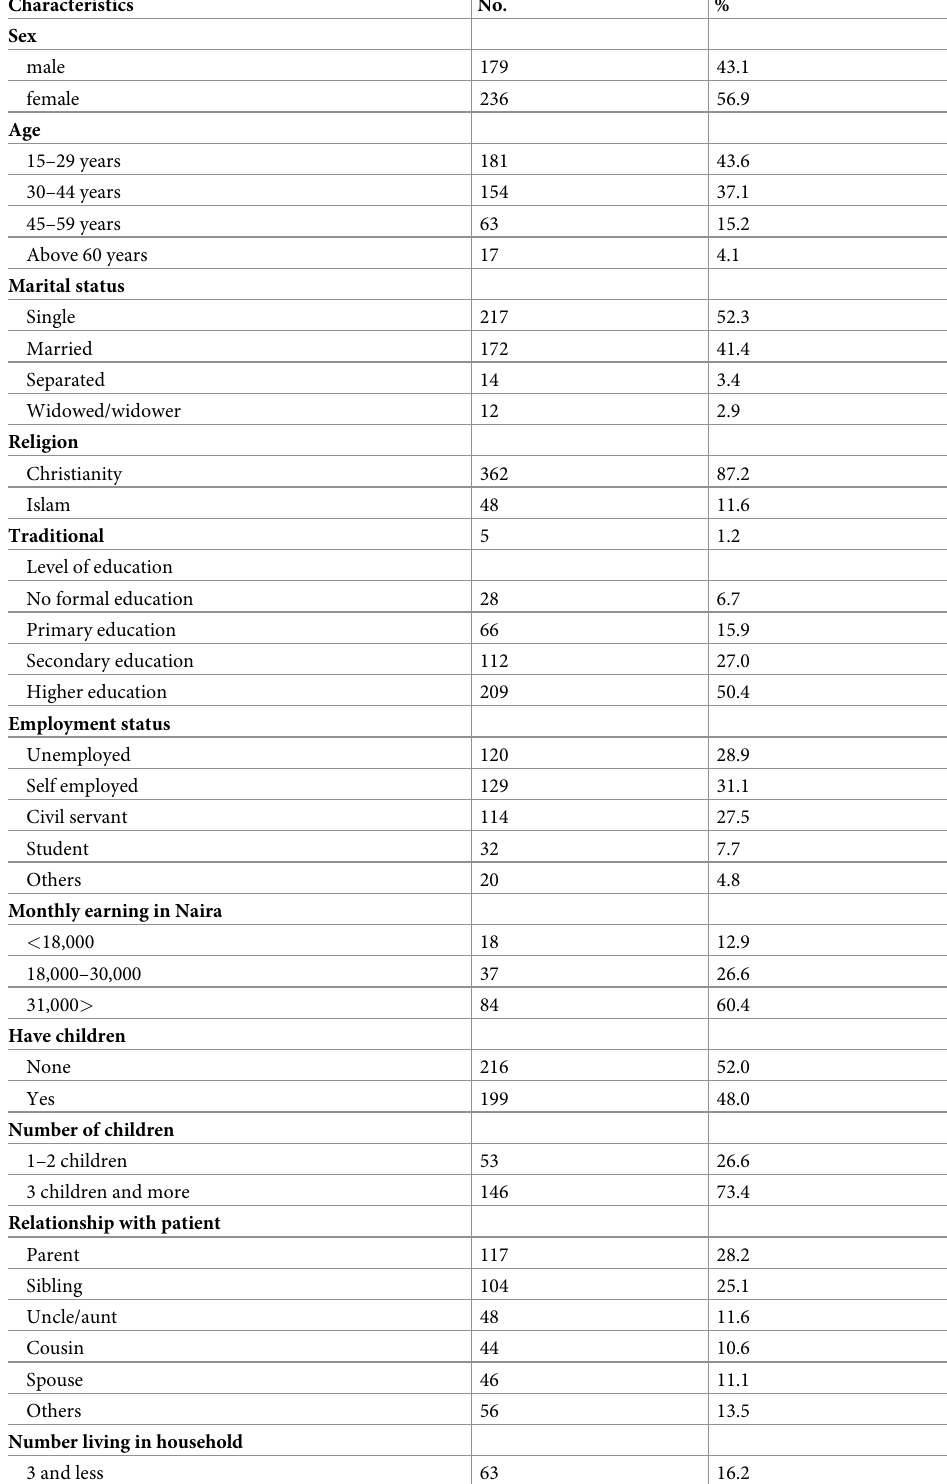
Table 1. Background characteristics of the